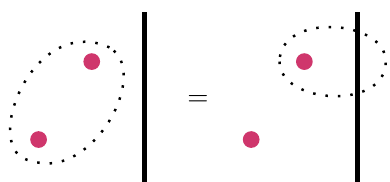
Figure 2. Pictorial representation of the crossing equation given in eq. (2.15). The correlator can be expanded in two ways, either by performing a bulk OPE (left-hand side) or a defect OPE (right-hand